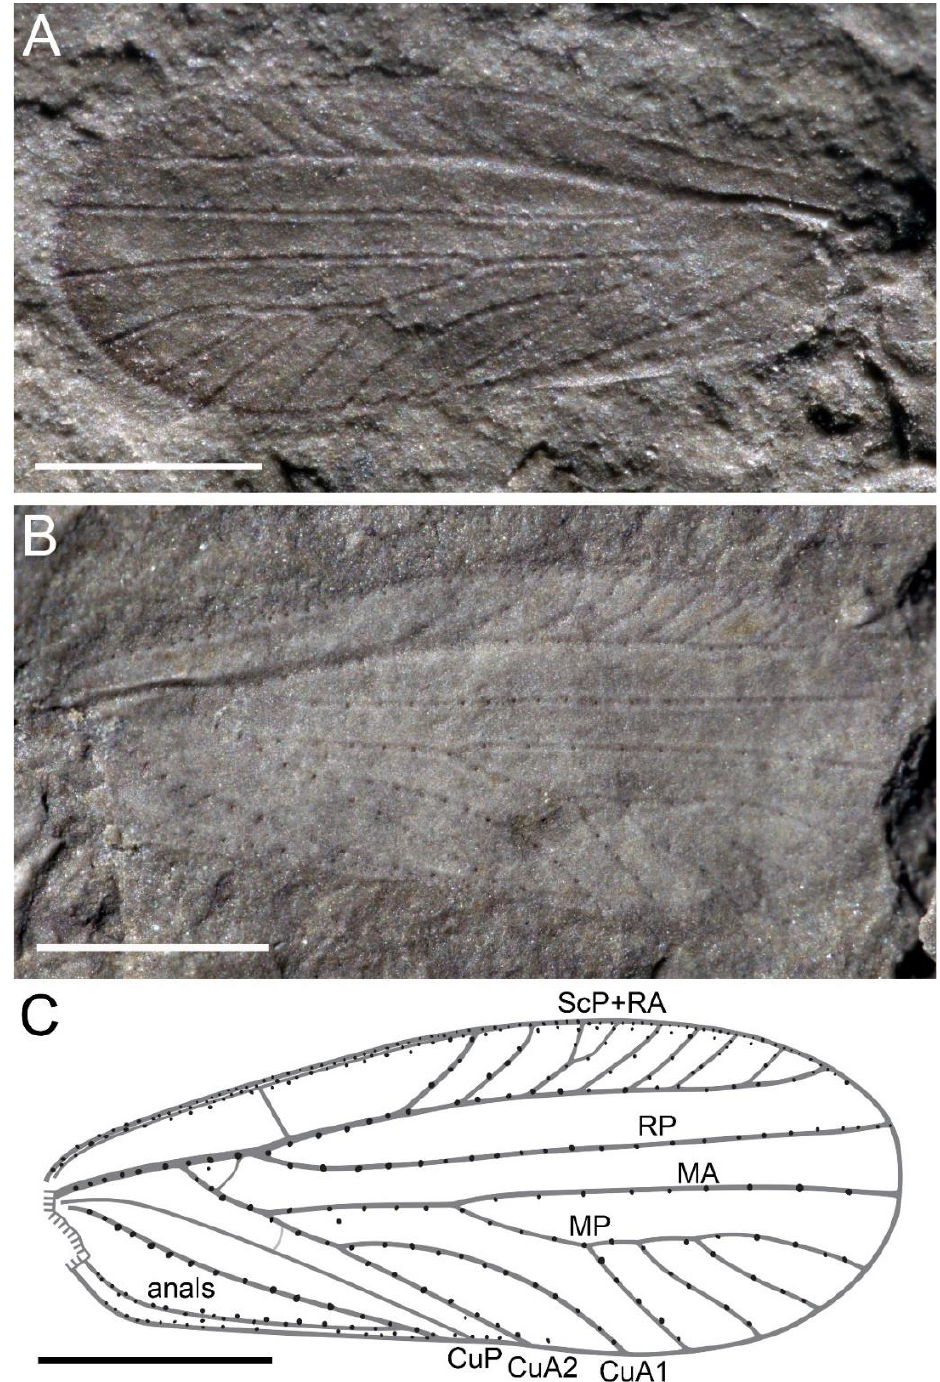
Figure 2. Triassopsyllidiida pectinata gen. et sp. nov., Middle Triassic Tongchuan biota, holotype NIGP180297, photographs of wing. ( A ) wing of counterpart; ( B ) wing of part; ( C ) line drawing. Scale bars: 1 mm.